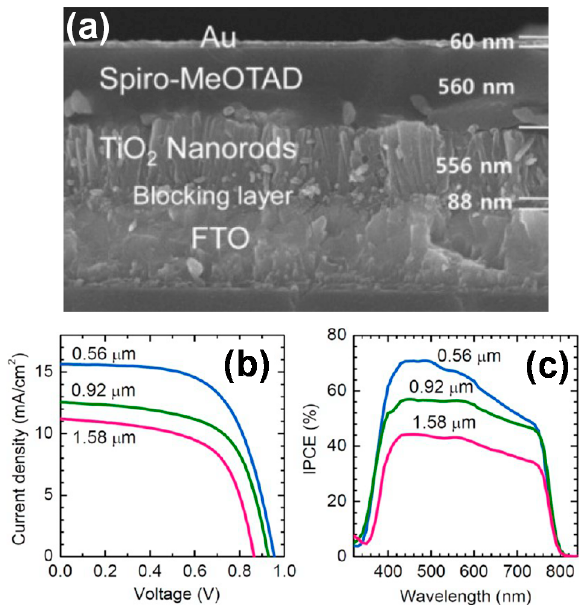
Figure 15. ( a ) Cross-sectional SEM image of 1D TiO 2 NR-PSCs; ( b ) I - V curves of 1D TiO 2 NR-PSCs with different lengths; and ( c ) IPCE of 1D TiO 2 NR-PSCs with different lengths. Reprinted with permission from [69]. Copyright 2013 American Chemical Society.